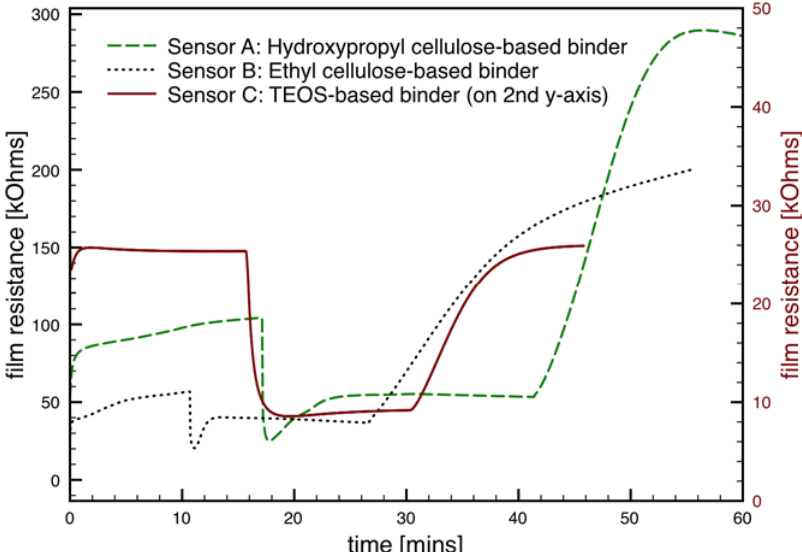
Figure 6. Representative SnO gas sensor response for sensors made using the three binder 2 recipes. The TEOS-based sensor resistance is plotted on the secondary y-axis to facilitate comparison of the